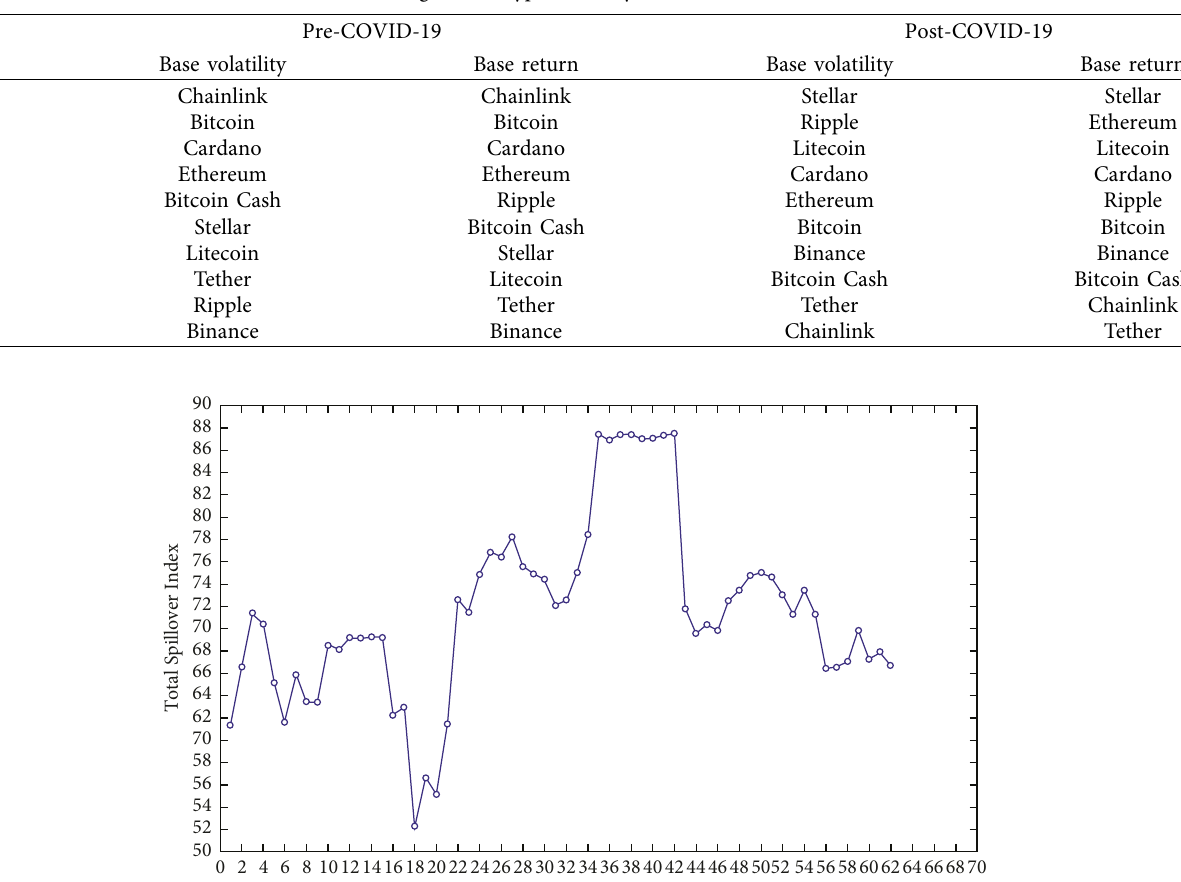
Table 7: Ranking list of cryptocurrency market under COVID-19.